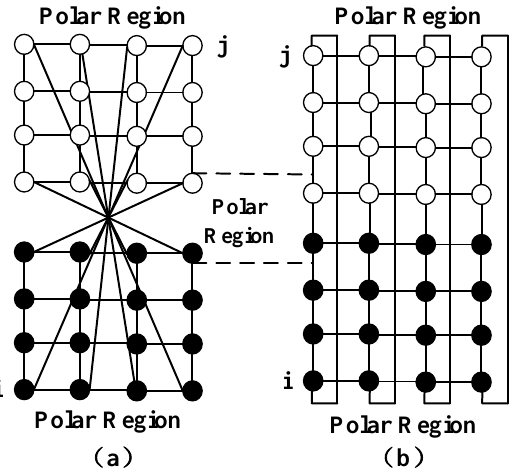
Figure 2. ( a ) Topology diagram of LEO satellites network. ( b ) Topology diagram of LEO satellites network with the upper half rotated 180°. Satellite i is still in its original position on the topology map, and the position of satellite j is changed on the topology map, but the topological connection relationship does not